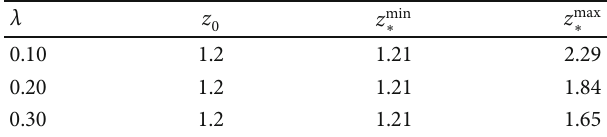
Figure 12: Surface plot satisfying the condition α = 1 . The region above and below the surface corresponds to α > 1 and α < 1 , respectively. The black lines show the range of integration for α ≥ 1 . The blue and green dots correspond to the value of z min ∗ and z max ∗ , respectively. Table 3: Parameter values used in Figure 4.